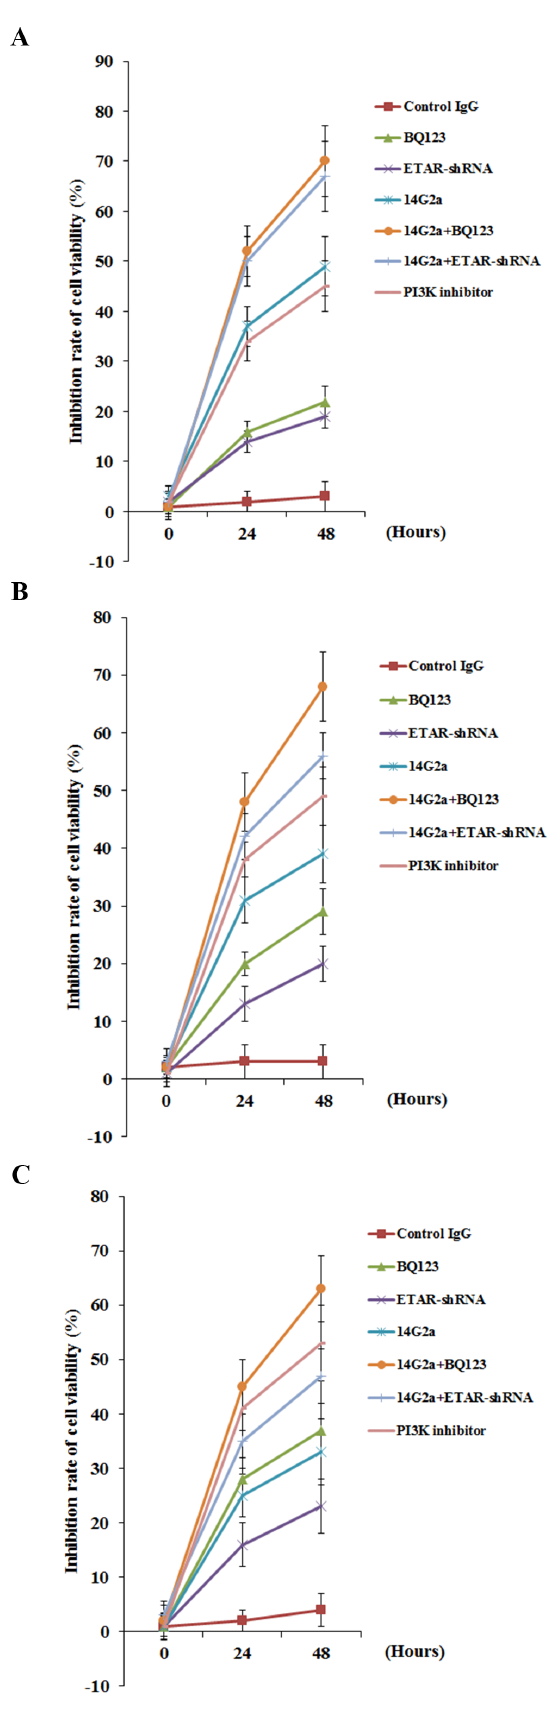
Figure 6. Effects of anti-ganglioside GD2 14G2a monoclonal antibody (mAb) alone or in combination with ET A receptor (ETAR) antagonist on osteosarcoma (OS) cell viability. Meth- lythiazoletetrazolium (MTT) cell viability assays were performed in Saos- 2 ( A ), MG-63 ( B ) and SJSA-1 ( C ) OS cells treated with control IgG (PK136 mAb, 50 m g/mL), 14G2a mAb (50 m g/mL), selective ETAR antagonist BQ123 (5 m M), and 14G2a (50 m g/mL) + BQ123 (5 m M) for 24 or 48 hours. Cells with knockdown of ETAR (ETAR-shRNA) with or without 14G2a mAb treatment were also tested. Cells treated with selective phosphatidylinositide 3-kinase (PI3K) inhibitor BKM120 (50 m M) was used as a positive control. Viability of the control cells was designated as 100%. The inhibition rate of cell viability was calculated and shown as a percentage of the control cell viability. Each experiment was repeated for three times in triplicates. Data values were expressed as Mean +